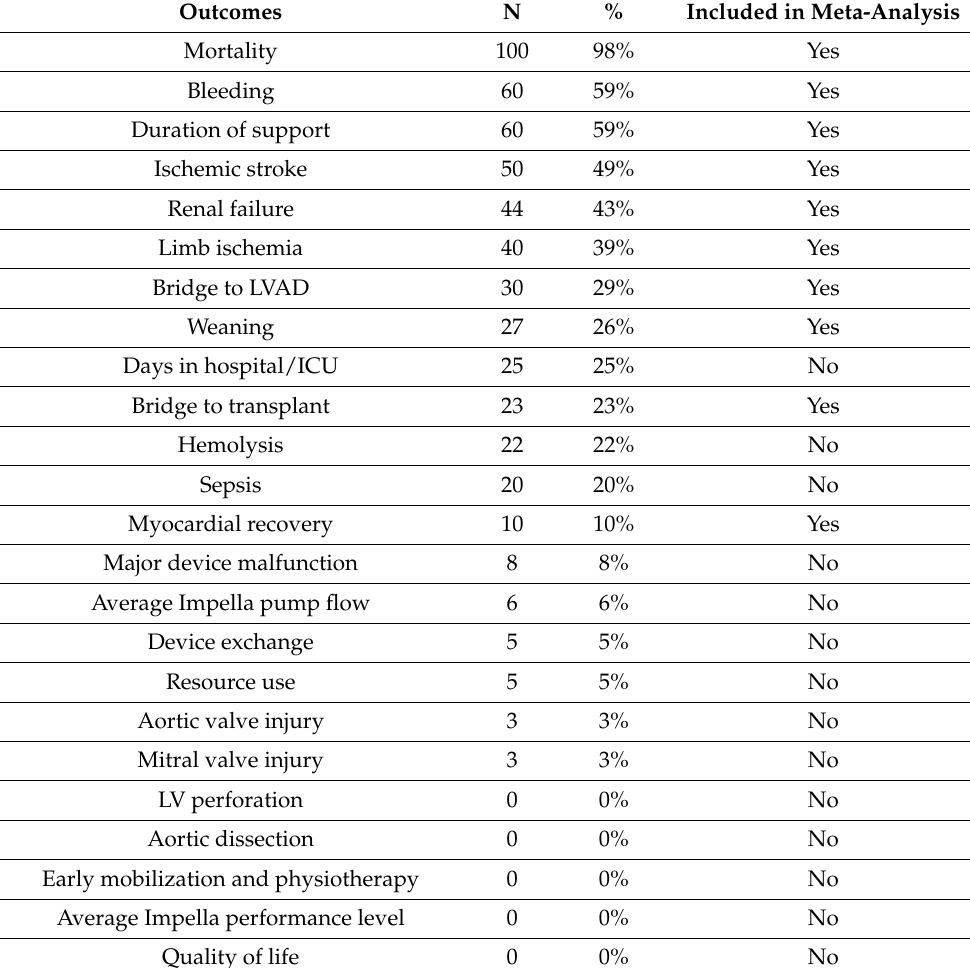
Table 1. Clinical outcomes extracted from selected